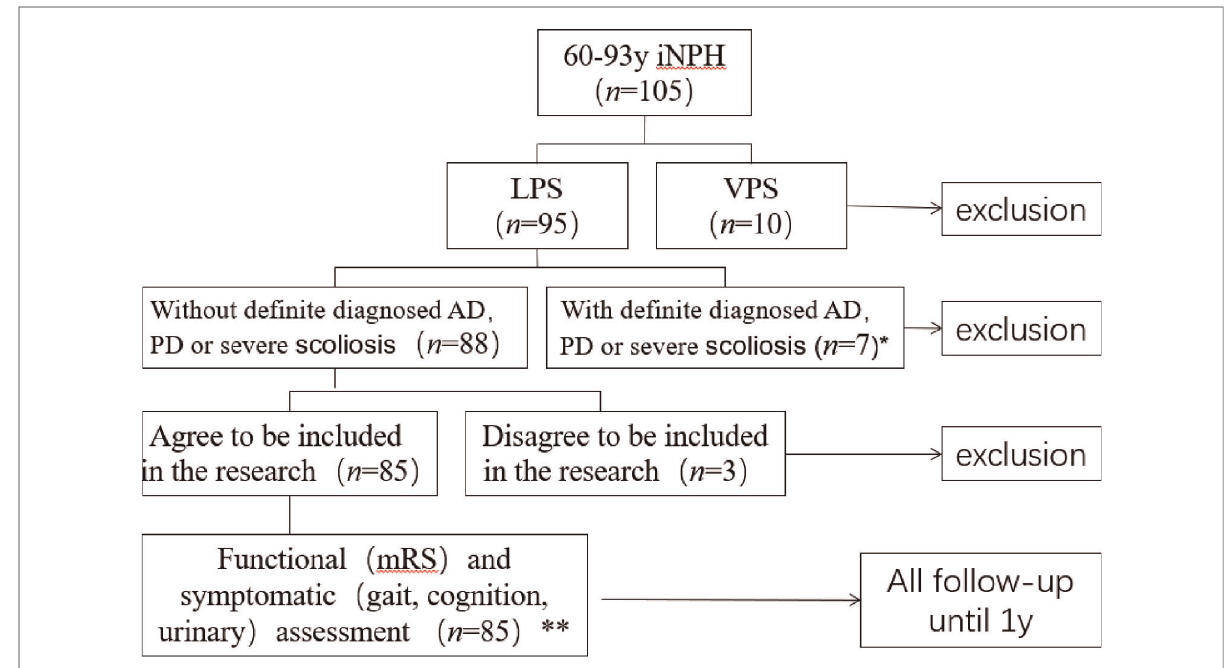
FIGURE 1 Flow chart of the study and the patient numbers from inclusion to fi nal